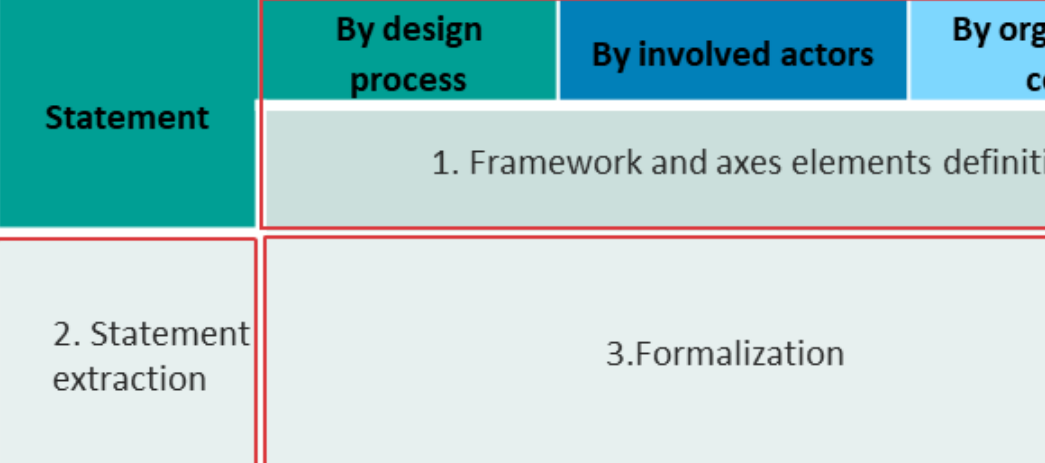
Figure 2. Qualitative analysis for the formalization carried out by the research team.